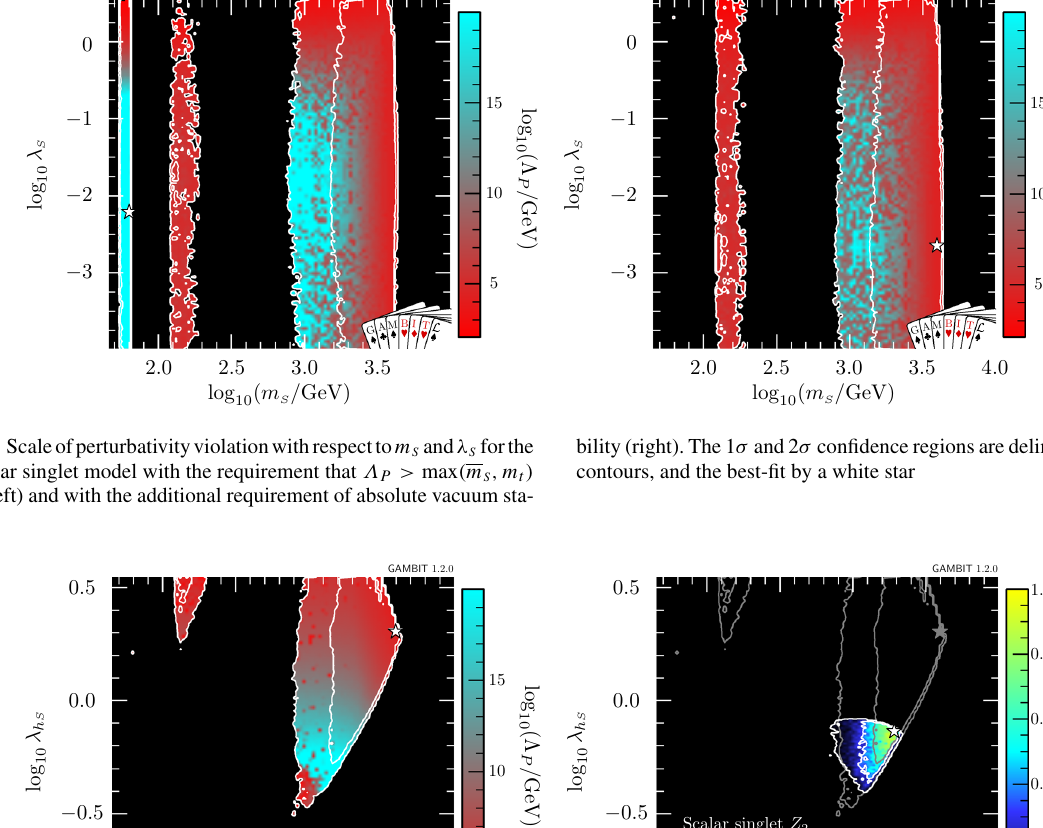
Scalar singlet Z 2 Stable vacuum only Λ P ≥ 10 15 GeV Prof. likelihood